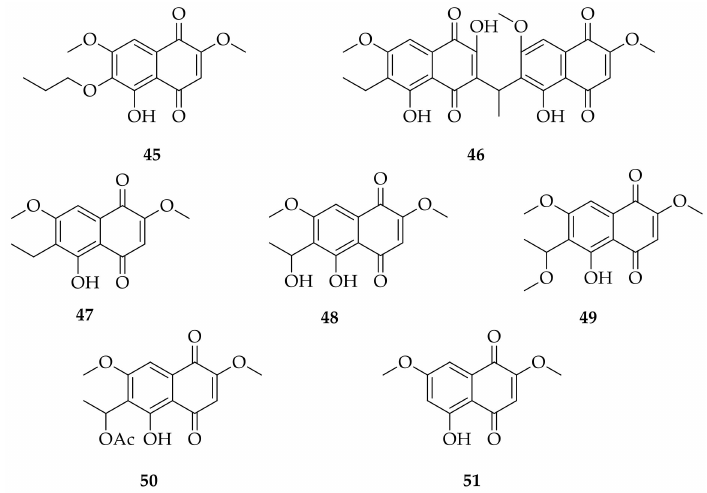
Figure 7. Structures of naphthoquinones: botryosphaenin, neofusnaphthoquinone A, 6-ethyl-2,7-dimethoxyyjuglone, 6-(1-hydroxyethyl)-2,7-dimethoxyjuglone, 6-(1-methoxylethyl)- 2,7-dimethoxyjuglone, 6-(1-hydroxyethyl)-2,7-dimethoxyjuglone monoacetate, 5-hydroxy-2,7- dimethoxynaphthalene-1,4-dione ( 45 – 51